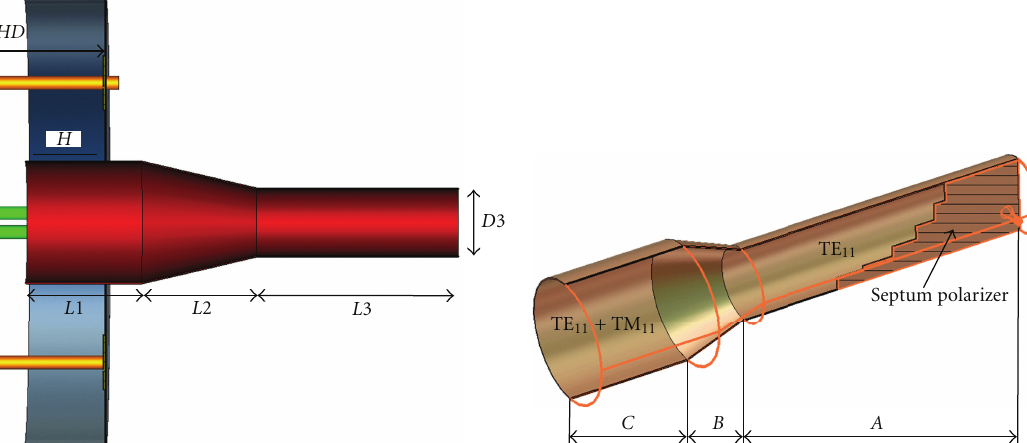
Figure 5: Layout of the dual-band feed, longitudinal cut (left) and internal view of the dual-mode horn equipped with five-step septum polarizer (right).